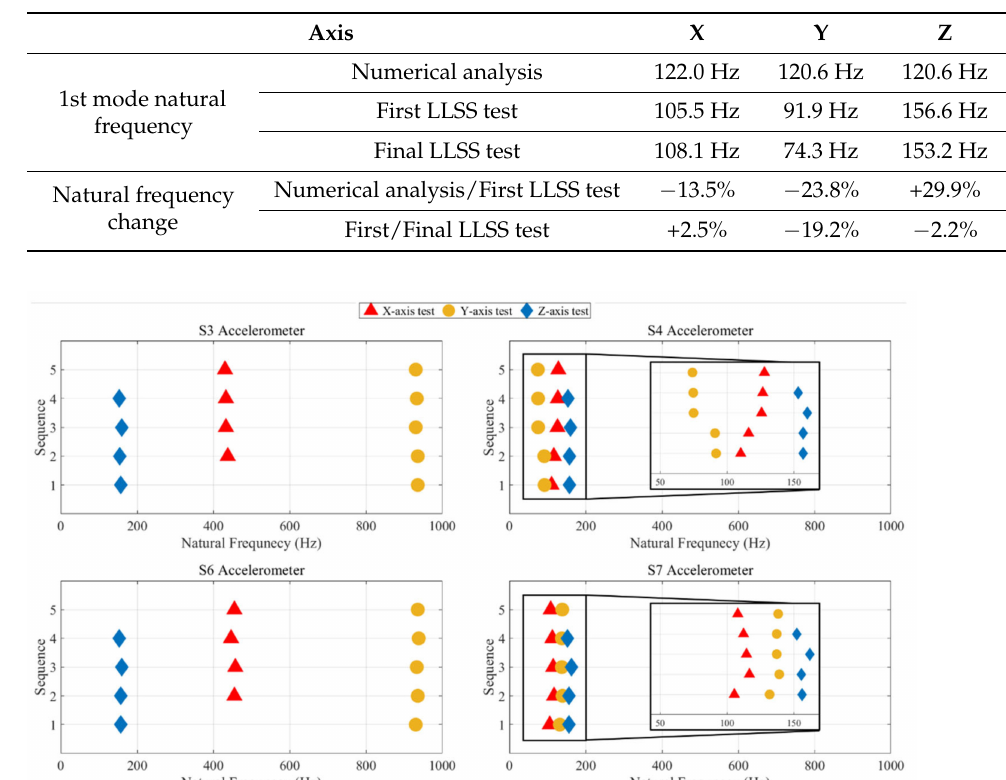
Figure 17. Modal survey results of the natural frequencies. The S3, S4, S6, and S7 accelerometers are located in the T-POD, − X-axis DSP of Pumbaa, − Y-axis DSP of Pumbaa, and +Z-axis panel of Pumbaa,